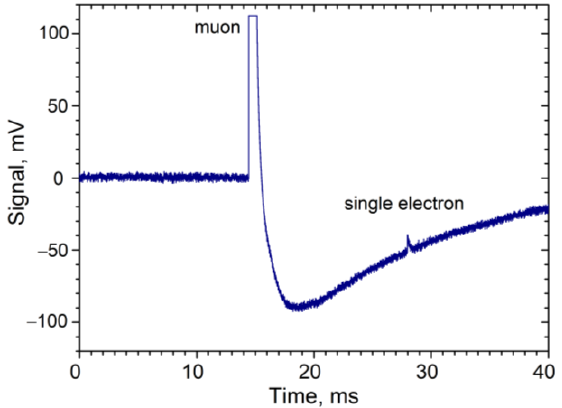
Figure 2. The pulses from muon and from single electron.